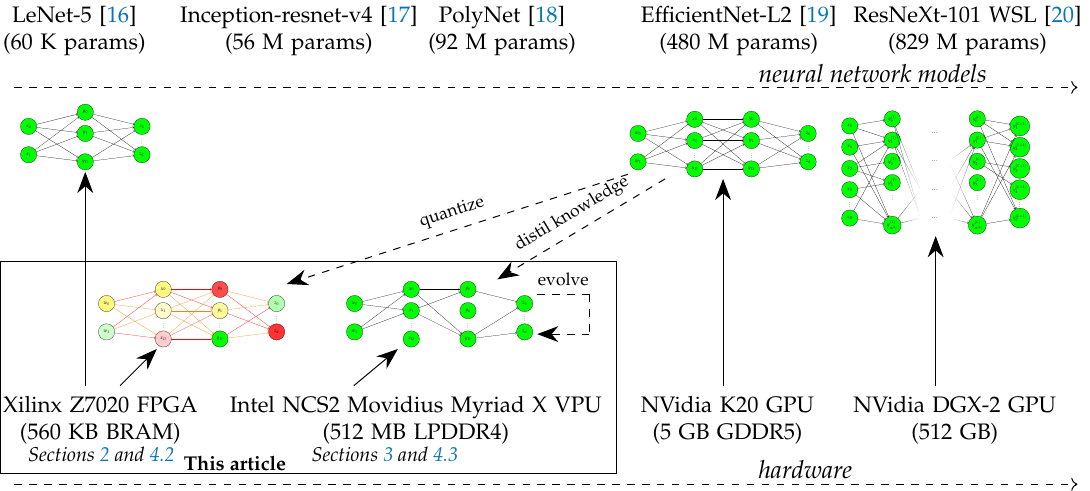
Figure 1. Meeting in the middle: compressing neural networks for acceleration. Neural network models vary hugely in their sizes, i.e. from 60 thousand parameters up to 900 million parameters. Figure 1 shows how compression such as quantization and knowledge distillation can put relatively large models within reach of high throughput hardware accelerators. Myriad X VPU, and (2) 1–8 bit precision quantisation of fixed neural networks targeting the Xilinx Z7020